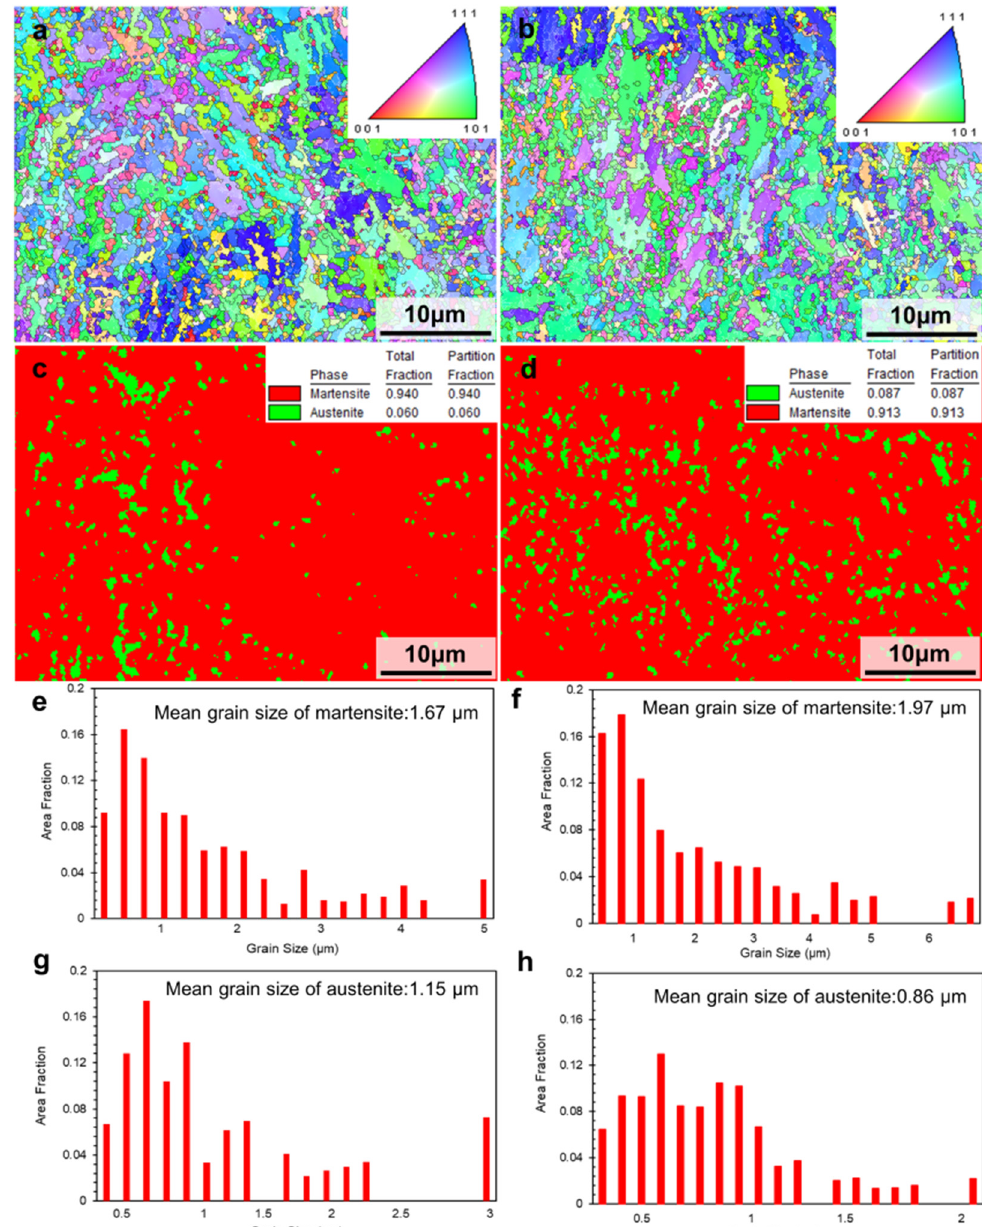
Figure 11. Inverse-pole figure (IPF) maps of the as-SLMed H13 specimens showing the grain orien- tations, phase maps and grain size distribution maps: ( a , c , e , g ) horizontal direction; ( b , d , f , h ) build- ing direction.